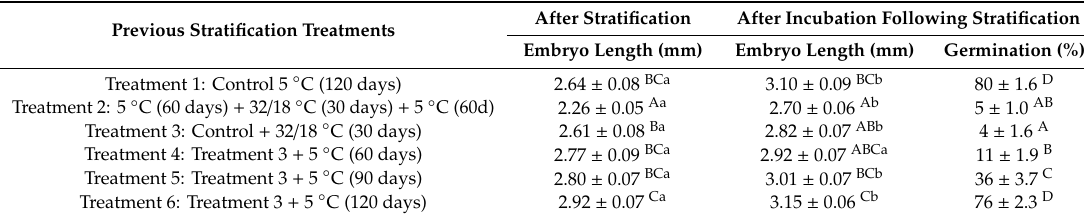
Table 4. Induction of dormancy by summer warm temperatures (32 / 18 ◦ C) and secondary dormancy the light. Incubation was applied at 15 / 4 ◦ C in darkness for 30 days. The table shows the embryo length (mm, mean ± standard error) and germination percentage in each treatment. Values followed by di ff erent uppercase letters within a column or di ff erent lowercase letters within a row are significantly di ff erent ( p < 0.05, Tukey’s multiple comparison